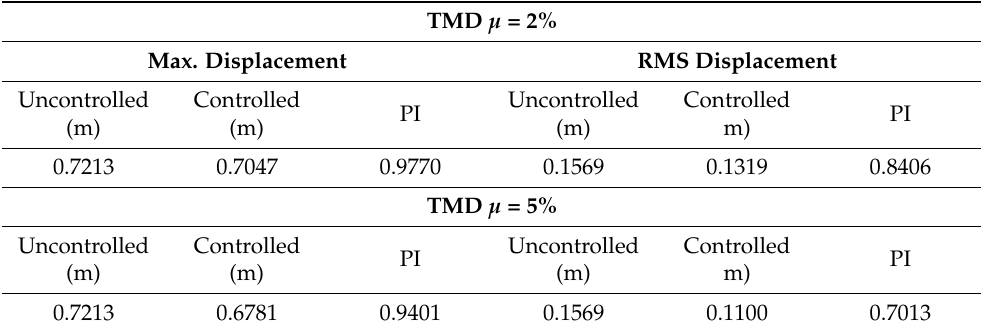
Table 7. Response parameters for the 32nd story of the structure subjected to Petrolia earthquake.